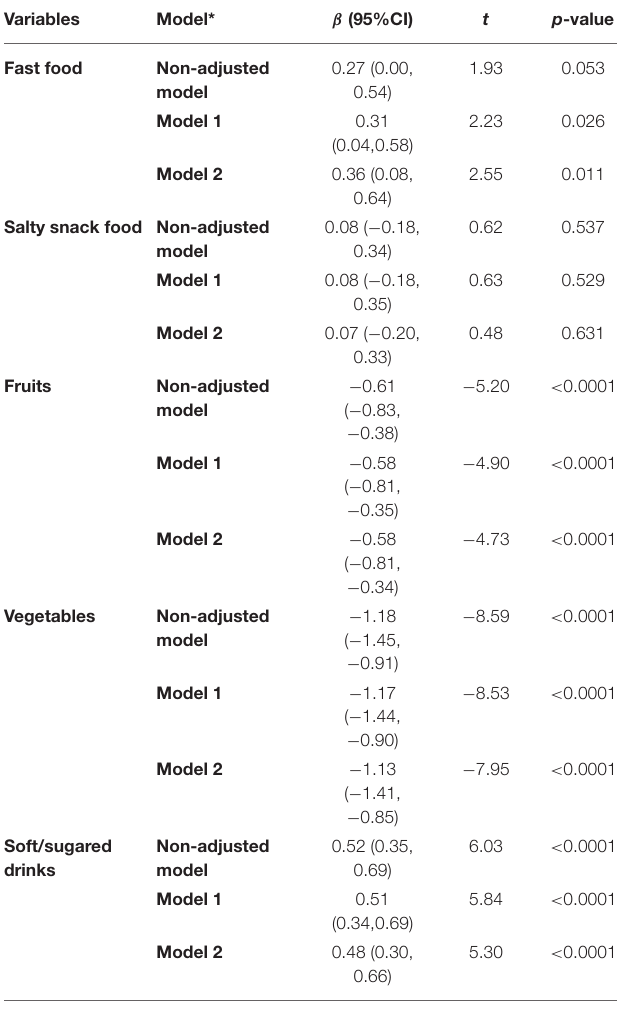
TABLE 3 | The associations between PSS-14 scores and each variable of food preference.